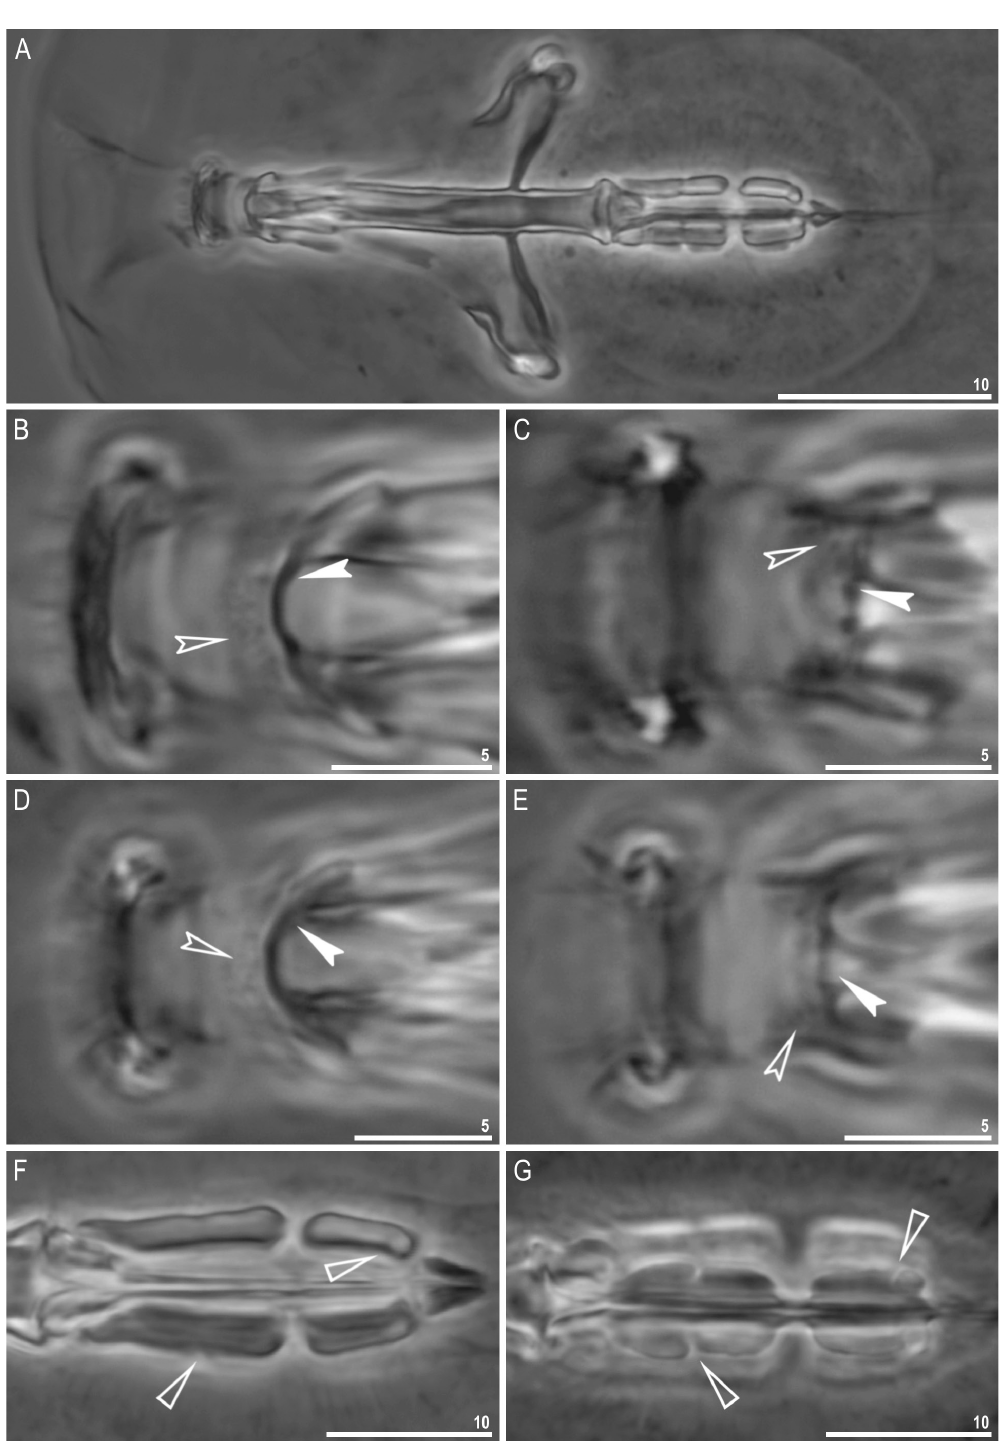
Fig. 12. Macrobiotus kamilae sp. nov., buccal apparatus and the oral cavity armature seen in PCM (paratypes, IZiBB). A . Dorso-ventral projection of the entire buccal apparatus. B–E . Oral cavity armature visible in dorsal (B, D) and ventral (C, E) views in a large and a small specimen, respectively. F–G . Placoid morphology visible in dorsal (F) and ventral (G) views, respectively. Empty indented arrowheads indicate the second band of teeth in the oral cavity, filled indented arrowheads indicate the third band of teeth in the oral cavity, whereas empty flat arrowheads indicate central constrictions in first macroplacoids and subterminal constriction in second macroplacoids. Scale bars in